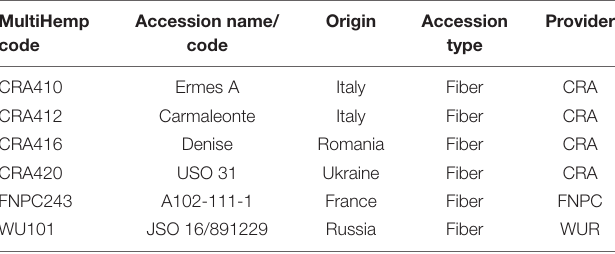
TABLE 1 | Six fiber hemp ( Cannabis sativa L.) accessions used in this study. MultiHemp